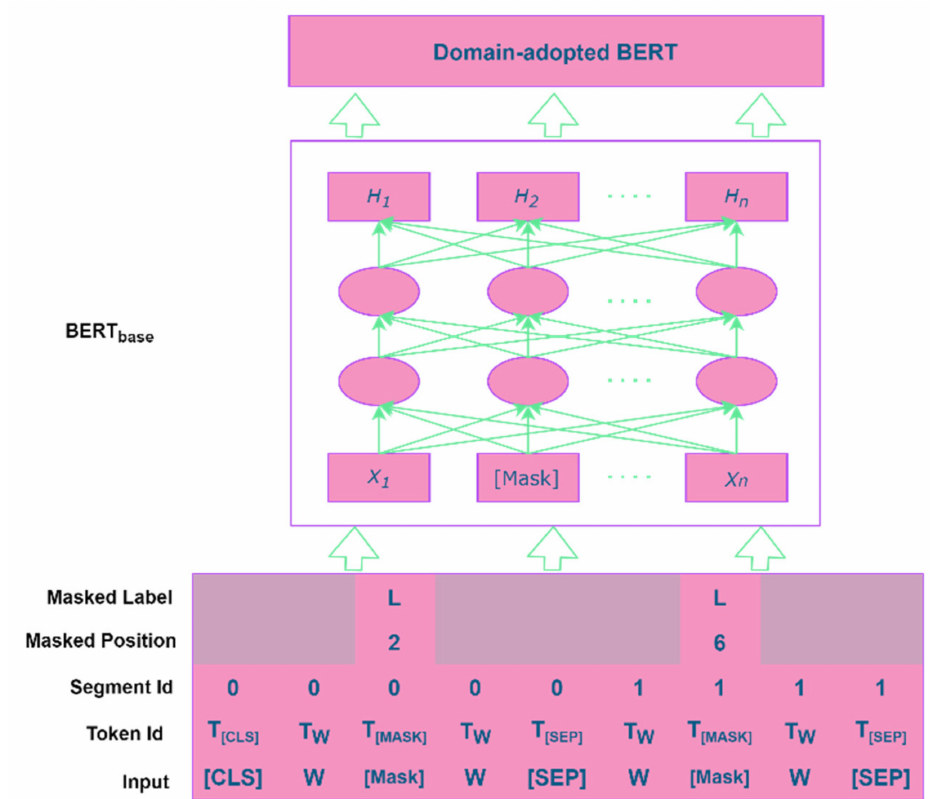
Figure 2. BERT post-training on domain